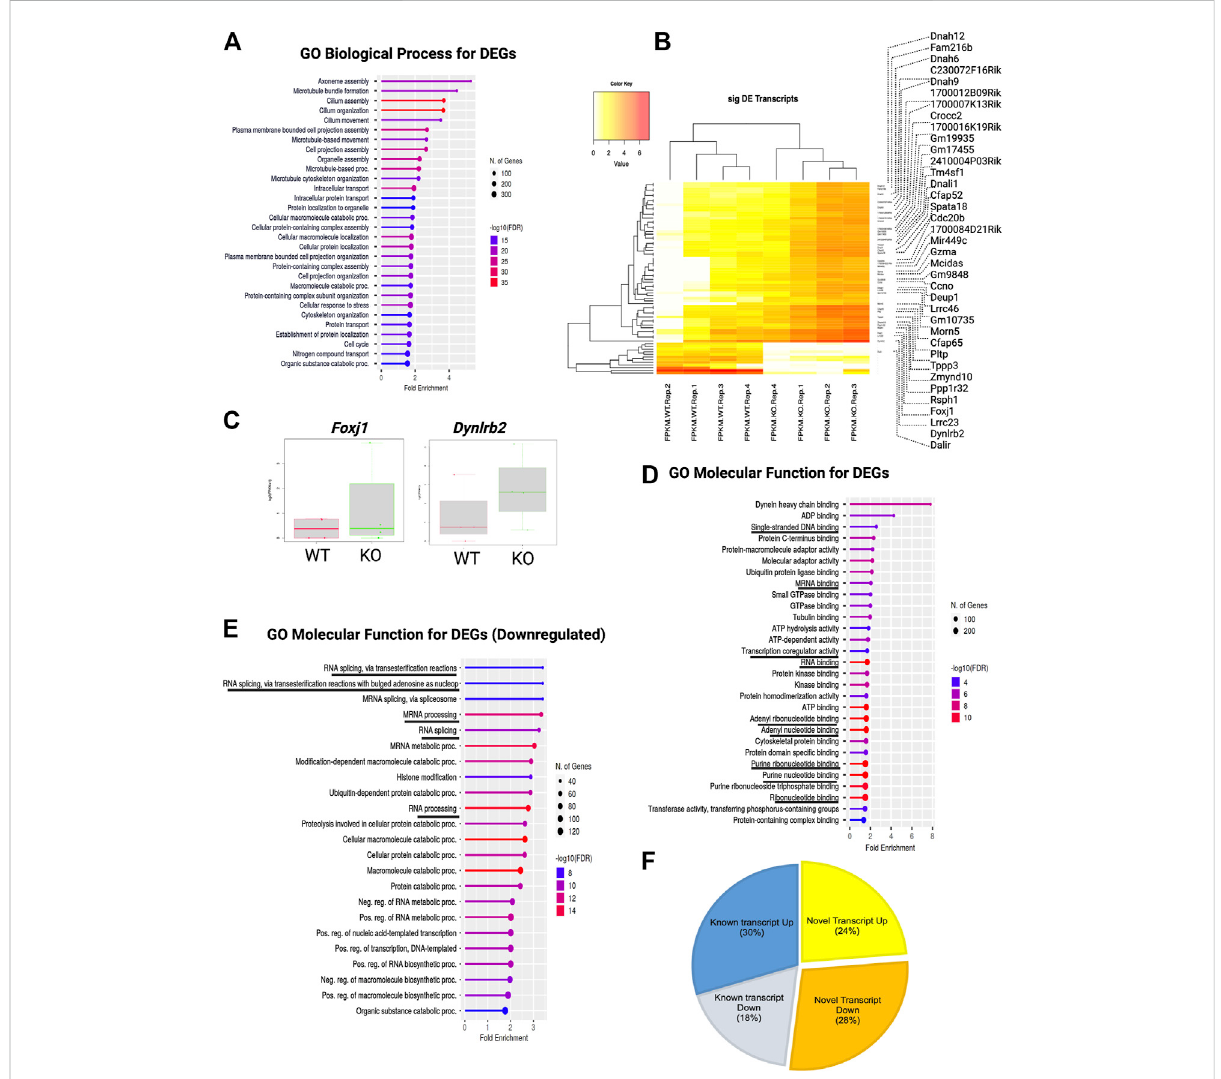
FIGURE 4 TSK de fi ciency dysregulate ependymal-like genes, posttranscriptional regulation, and levels of variant transcripts. (A) Top 30 GO biological processcategoriessigni fi cantlyenrichedinDEGs.Thebluetoredgradientofthelollipopindicates-logFDRvalue.Thelengthofthelollipopindicates fold enrichment. The size of the lollipop tip indicates the number of positive gene hits in relevant categories. (B) Heatmap of signi fi cant ( p < 0.05) differentially expressed (DE) transcripts (Log2FC ≥ 2) between WT and KO samples. The yellow to red gradient indicates the level of expression. Unnamedrowsintheheatmapgenecolumnindicatenovel transcripts. (C) FPKM distributionof Foxj1 and Dynlrb1 ependymalcellmarkersinWTand KO groups. (D) Top 30 GO molecular function categories signi fi cantly enriched in DEGs. A black underline indicates terms associated with nucleic acid binding. (E) Top 30 GO molecular function categories signi fi cantly enriched in DEGs with decreased expression. A black underline indicates terms associated with posttranscriptional regulation-related RNA binding. (F) Percentage distribution of novel and known transcripts in differentially expressed transcripts. Up and down indicates increase and decrease of the expression